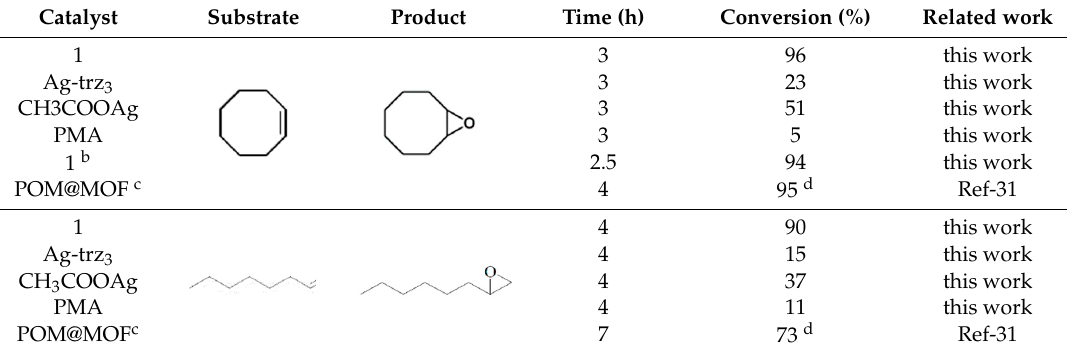
Table 1. Catalytic epoxidation of cyclooctene and 1-octene with O 2 /IBA over various catalysts. a.